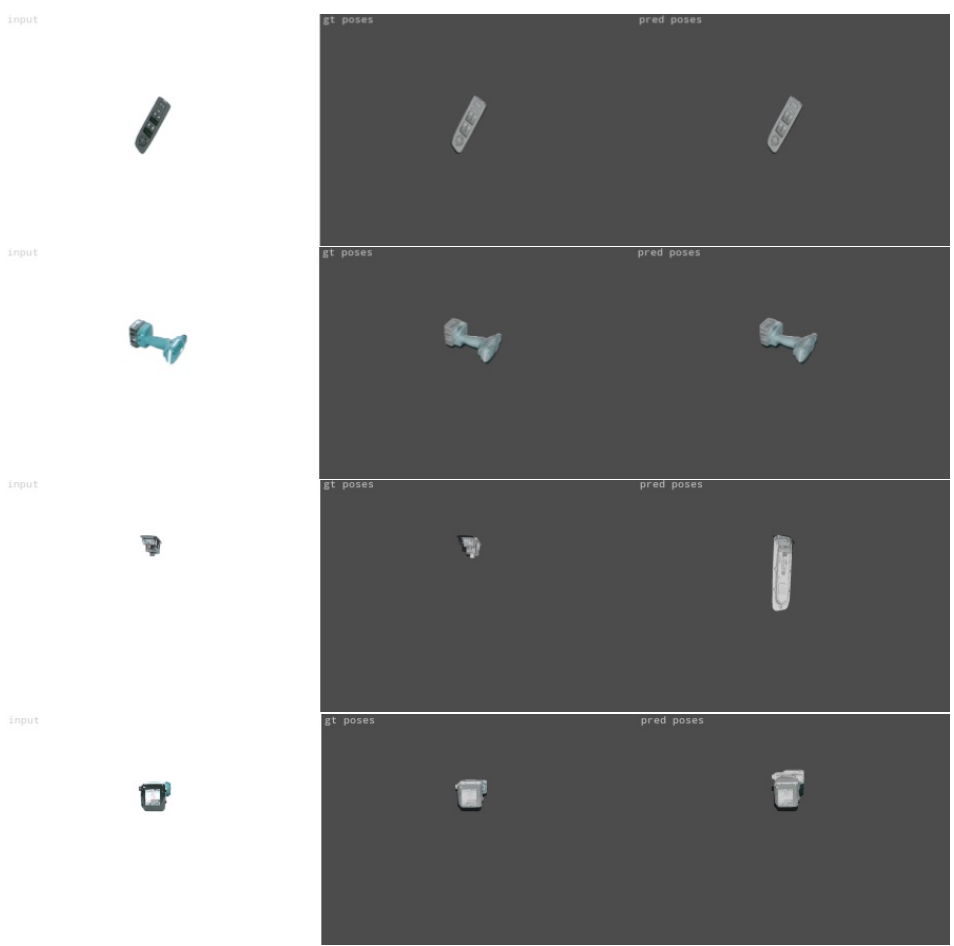
Figure 13. Examples of precise predictions (first and second rows) and of incorrect predictions (third and fourth rows) on masked images. The first column presents the input validation image, the second column the ground truth and the third one the estimated object